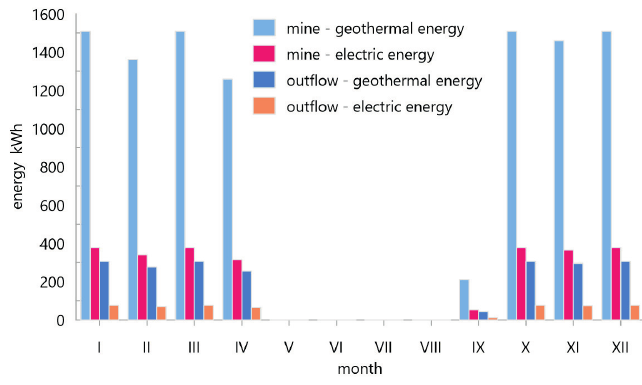
Figure 8. Geothermal energy production and electrical energy